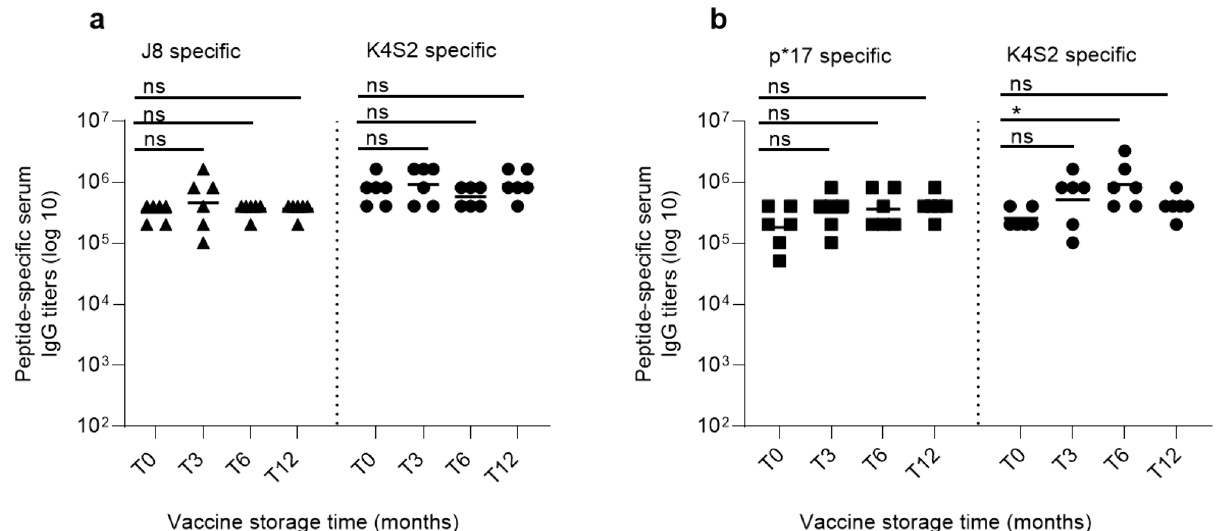
Figure 4. Stability of vaccines. Peptide specific serum IgG titers induced in Sprague–Dawley rats, after vaccination with J8-CRM + K4S2-CRM/Alum or p*17-CRM + K4S2-CRM/Alum stored for 0, 3, 6 and 12 months, were compared. Sprague–Dawley rats were immunized once intramuscularly with 0.1 mg/dose of J8-CRM + K4S2-CRM/Alum or p*17-CRM + K4S2-CRM/Alum. 18 ± 2 days following immunization, rats were bled. J8, p*17and K4S2 specific serum IgG titers are shown. IgG titers in rats (n = 6; 3 male, 3 female) vaccinated with J8-CRM + K4S2-CRM/Alum ( a ) or p*17-CRM + K4S2-CRM/Alum ( b ) stored for 0 (T0), 3 (T3), 6 (T6) and 12 months (T12). Samples were considered positive when the mean value of the absorbance, of the highest dilution (1:100) was 3SD above the mean OD of the negative control. Statistical analysis using a Mann–Whitney test to compare all groups to the T0 group, were performed using GraphPad Prism (8.1.2). * p <